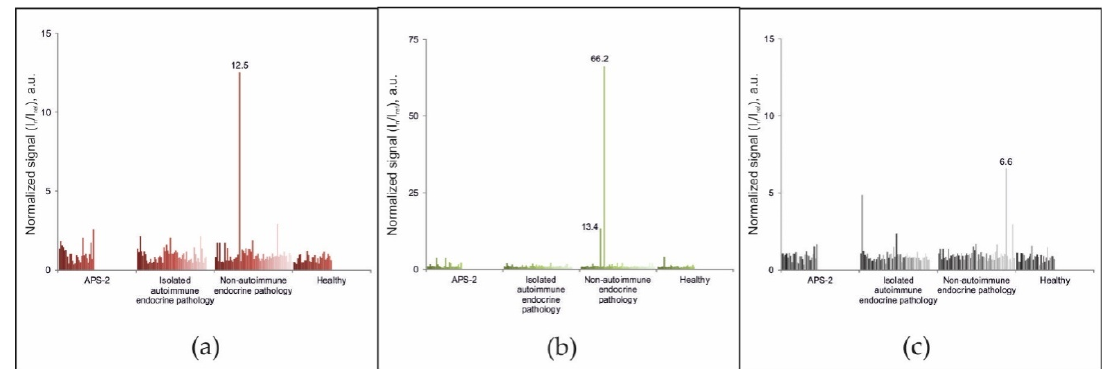
Figure 3. Normalized signals for autoantibodies against ( a ) IFN-ω; ( b ) IFN-α-2a; and ( c ) IL-22 ( c ) in serum samples from non-APS-1 patients, as determined by the microarray-based assay.